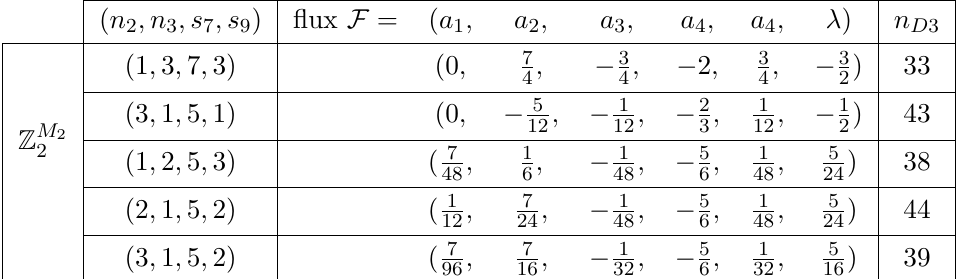
Table 4 . The summary of geometric and (cid:13)ux data that lead to three chiral generations in the Z M 2 matter parity assignment. The (cid:12)rst two con(cid:12)gurations each contain a redundant (cid:13)ux parameter; we chose to eliminate this redundancy by setting a 1 = 0. For completeness, we have also included the